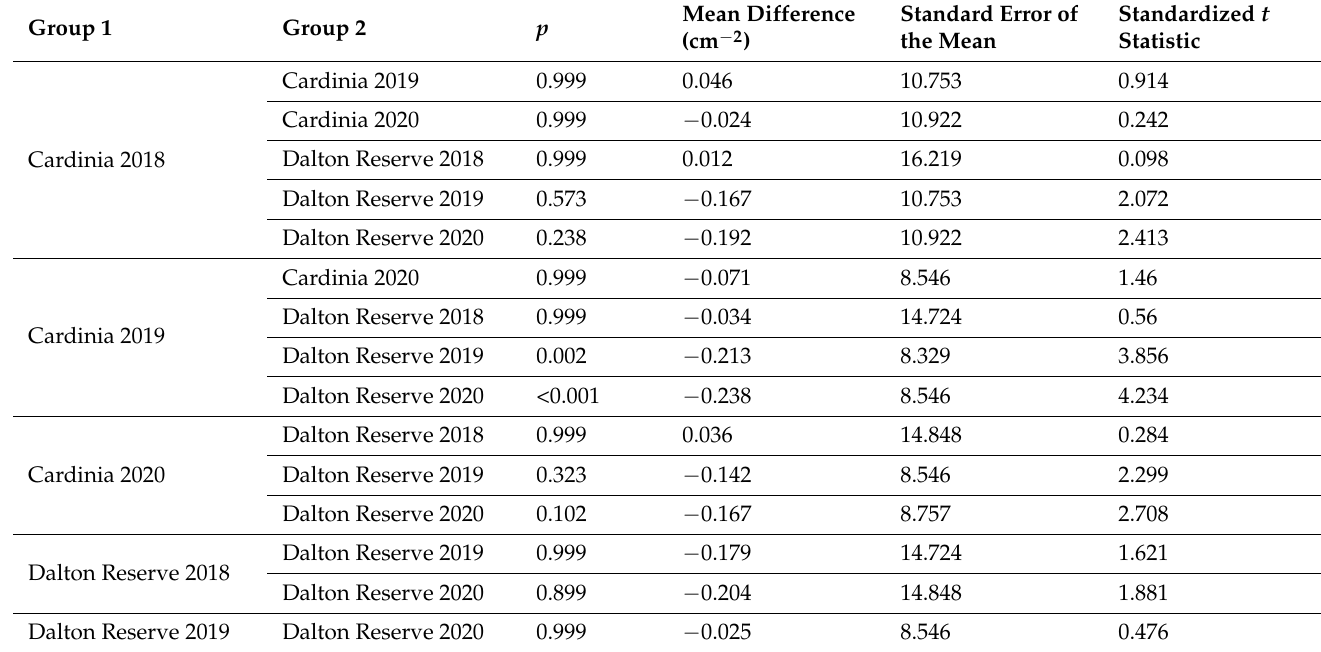
Table A6. Summary of Kruskal-Wallis pairwise comparison testing for differences in the density of honeydew producing nymphs (cm − 2 ) between site and generation groups.